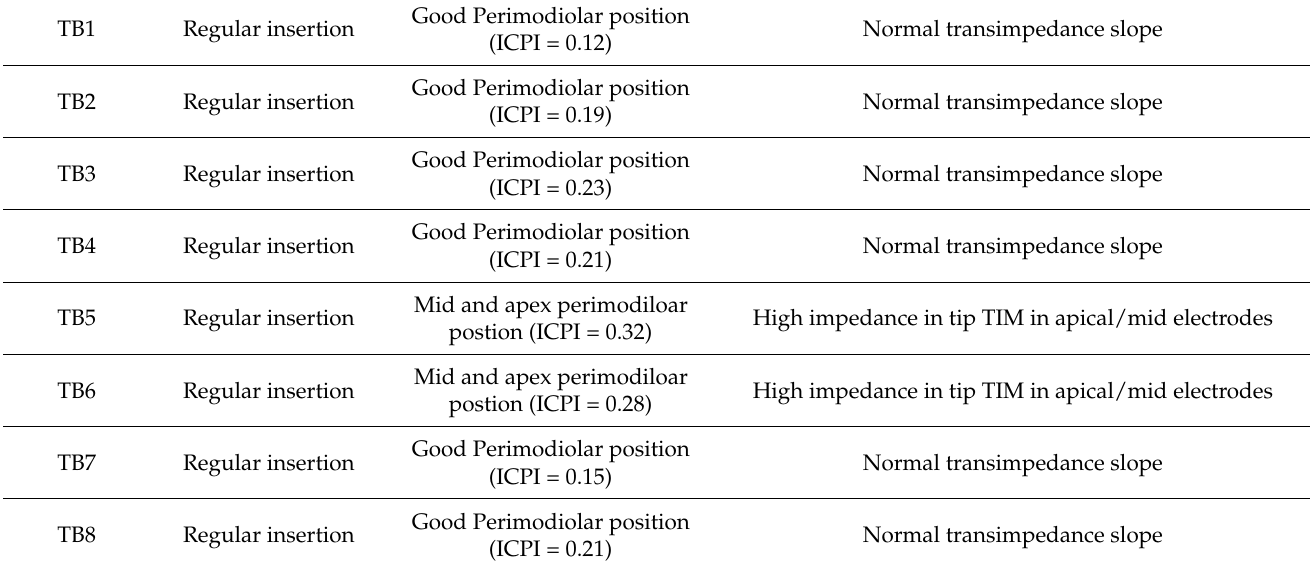
Table 2. Temporal bones (TB), regular insertions. Electrode array position was analyzed in terms of the modiolar proximity of each electrode contact and TIM patterns.